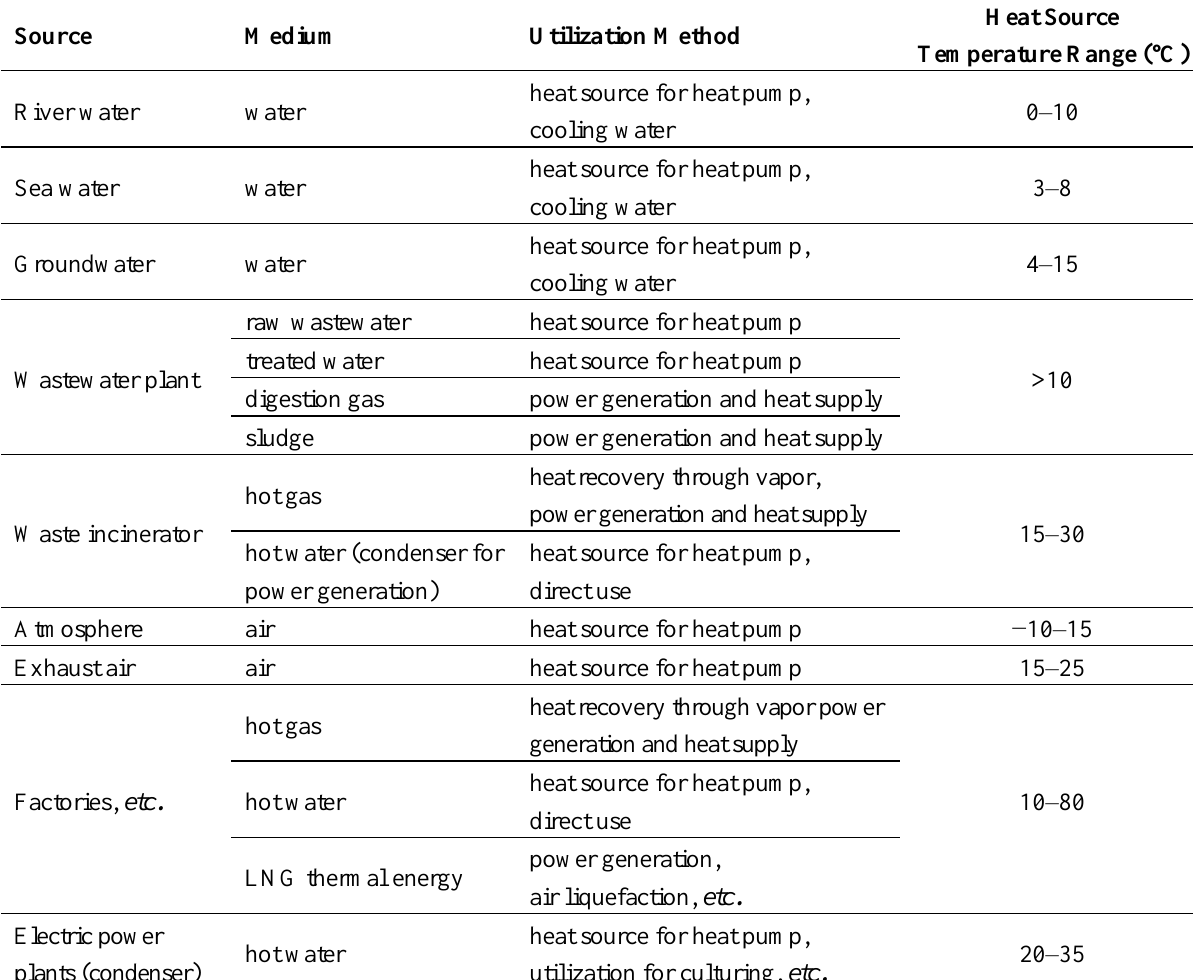
Table 1. Utilization of unused